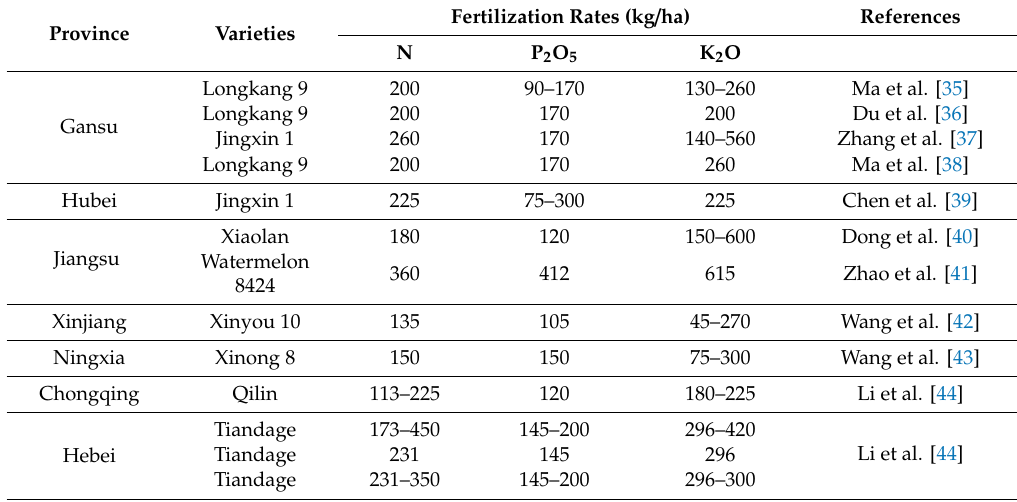
Table 1. Fertilization rates in fields across